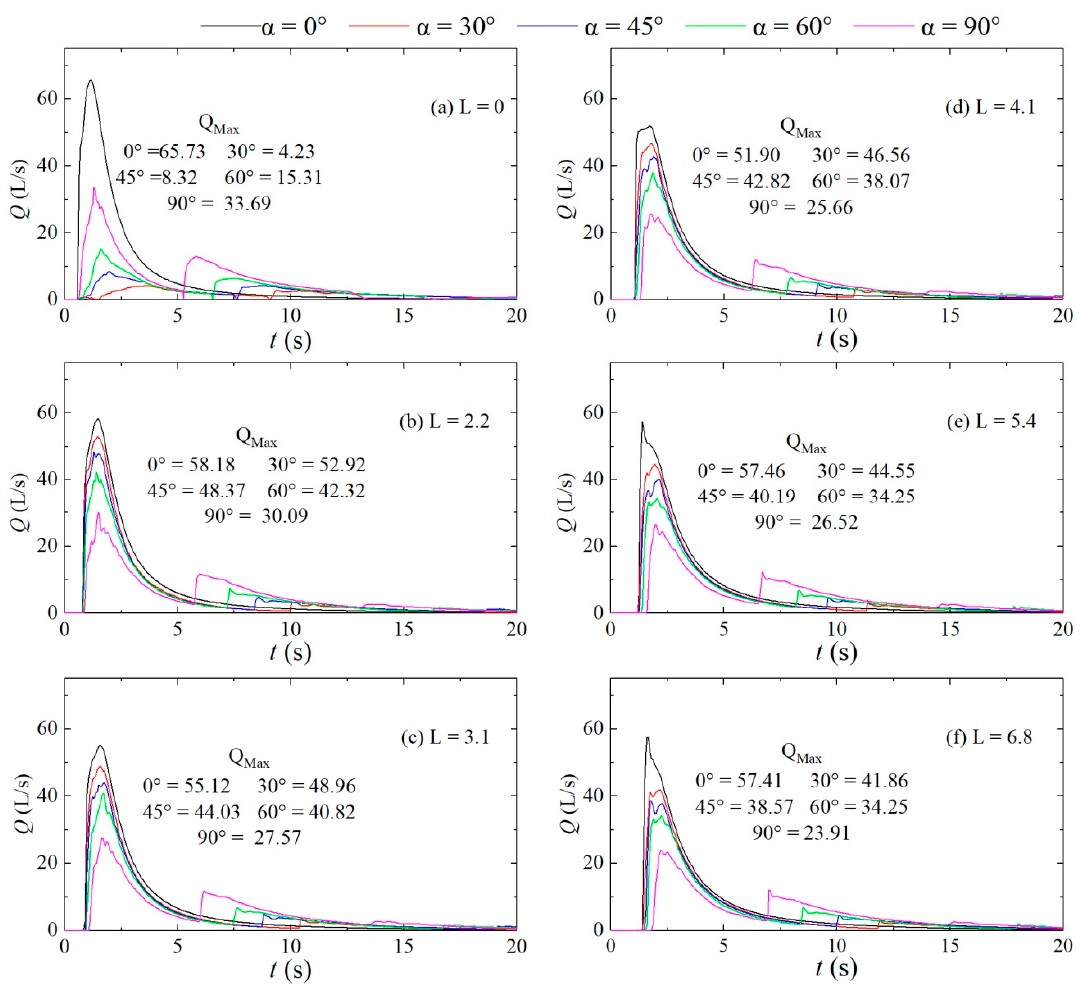
Figure 17. Flow discharge hydrographs for the downstream straight sections of different configurations. ( a ): L = 0; ( b ): L = 2.2; ( c ): L = 3.1; ( d ): L = 4.1; ( e ): L = 5.4; ( f ): L = 6.8.